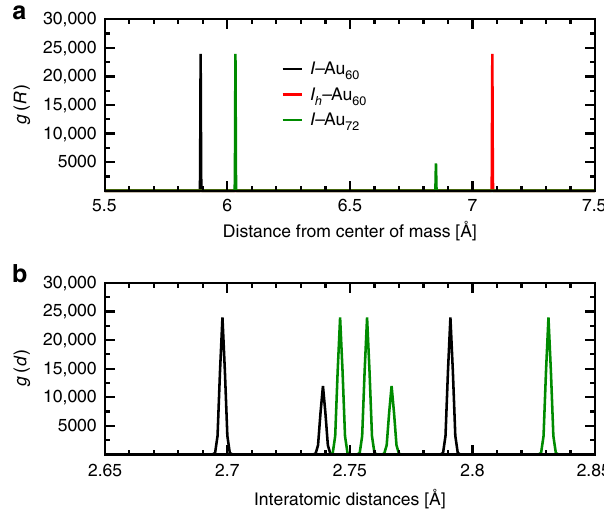
Fig. 2 Atomic structure comparison of I − Au 60 , I h − Au 60 , and C 1 − Au 60 clusters. a Radial distribution functions for the three icosahedral shells depicted in Fig. 1c, e, g. The initial I h − Au 60 structure (red) has a radius of ~7.1 Å, i.e., all 60 atoms lie precisely 0.71-nm from the center-of-mass. The fi nal structure (black), I − Au 60 , is nearly 5.9 Å in radius, or 1.18-nm in diameter. The I − Au 72 structure (green) exhibits two radii, of 6.03 and 6.86 Å, in the ratio 60:12, and re fl ects the two distinct sets of symmetry- equivalent sites. The surprisingly large contraction of the chiral icosahedral shell I − Au 60 (black) structure indicates unusually short (strong) bonds, and a high coordination number (5). b Comparison of bond lengths (nearest-neighbor distances) in the optimized I − Au 60 (black) and I − Au 72 (green) structures depicted in Fig. 1e, (2.70 Å), blue in Fig. 1e, compose the 12 regular pentagons in the I − Au 60 structure, and map directly onto the Archimedean polyhedron in Fig. 1f. These distances are nearly 9% contracted from that of the bulk FCC gold. These same bonds become the longest ones (2.83 Å) in the I − Au 72 structures, the green peak at